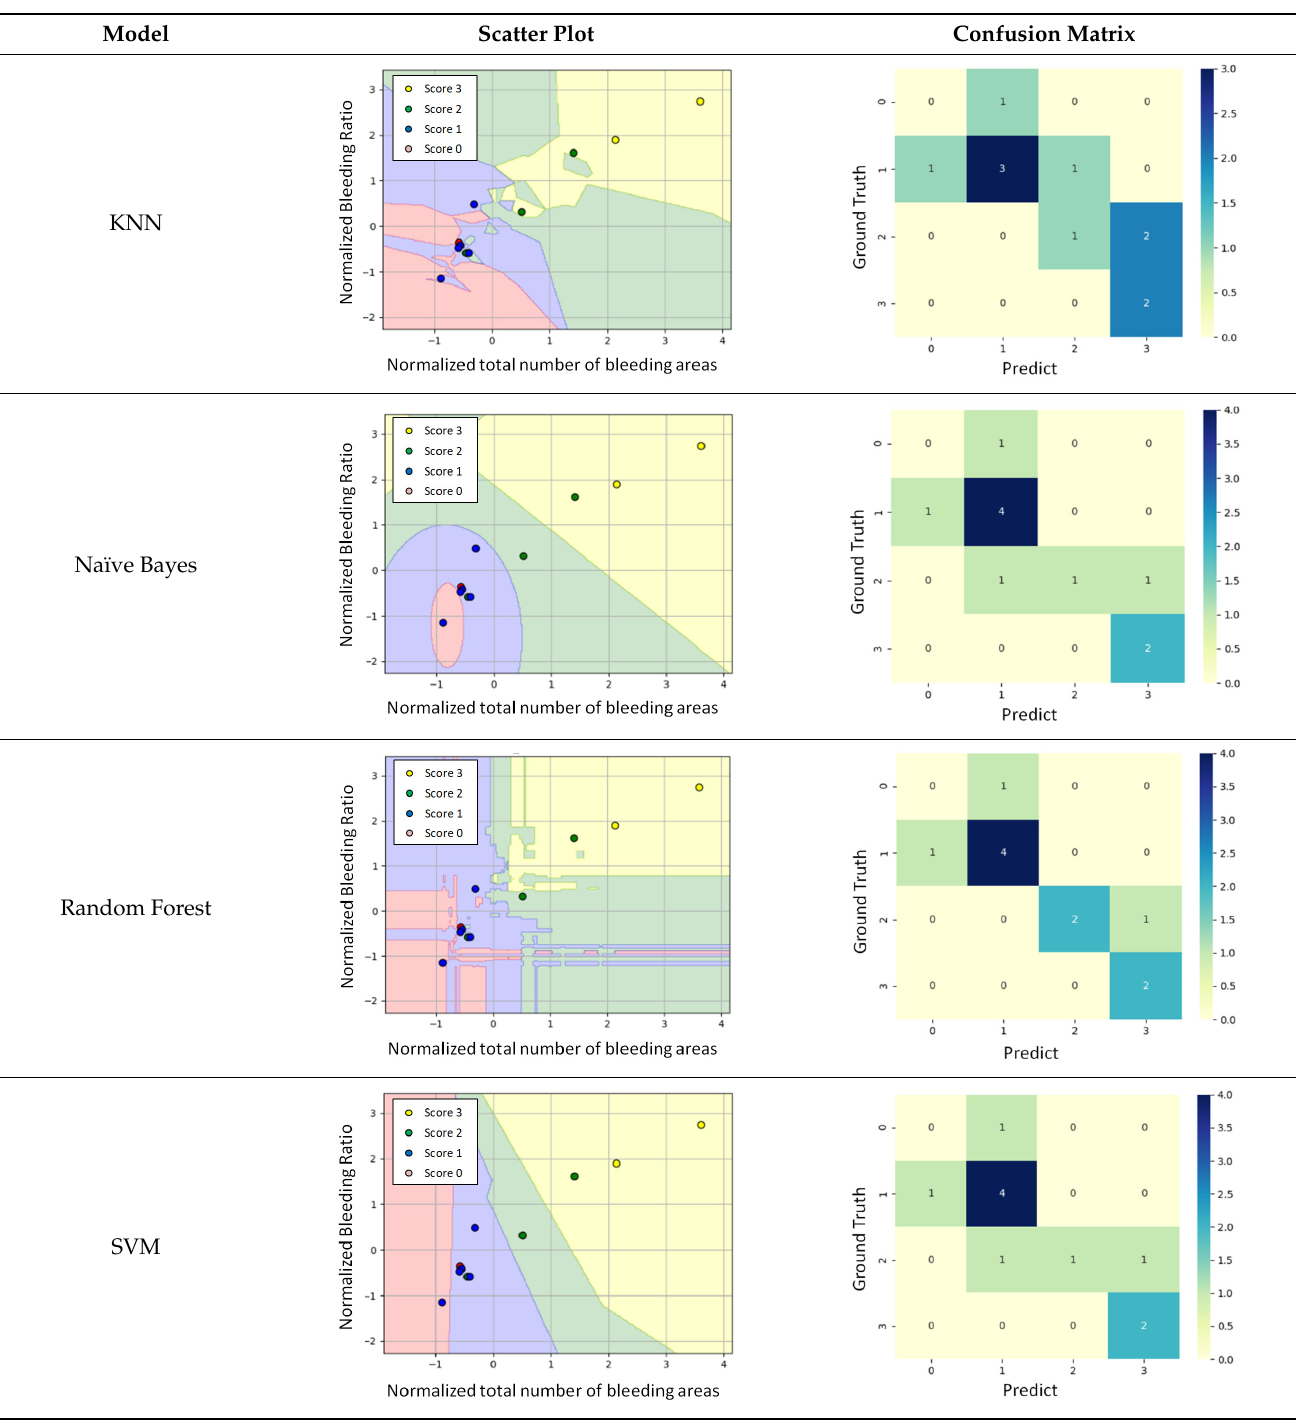
Table 1. Qualitative comparison of the four machine learning models for evaluating the levels of blood loss in the validation stage.